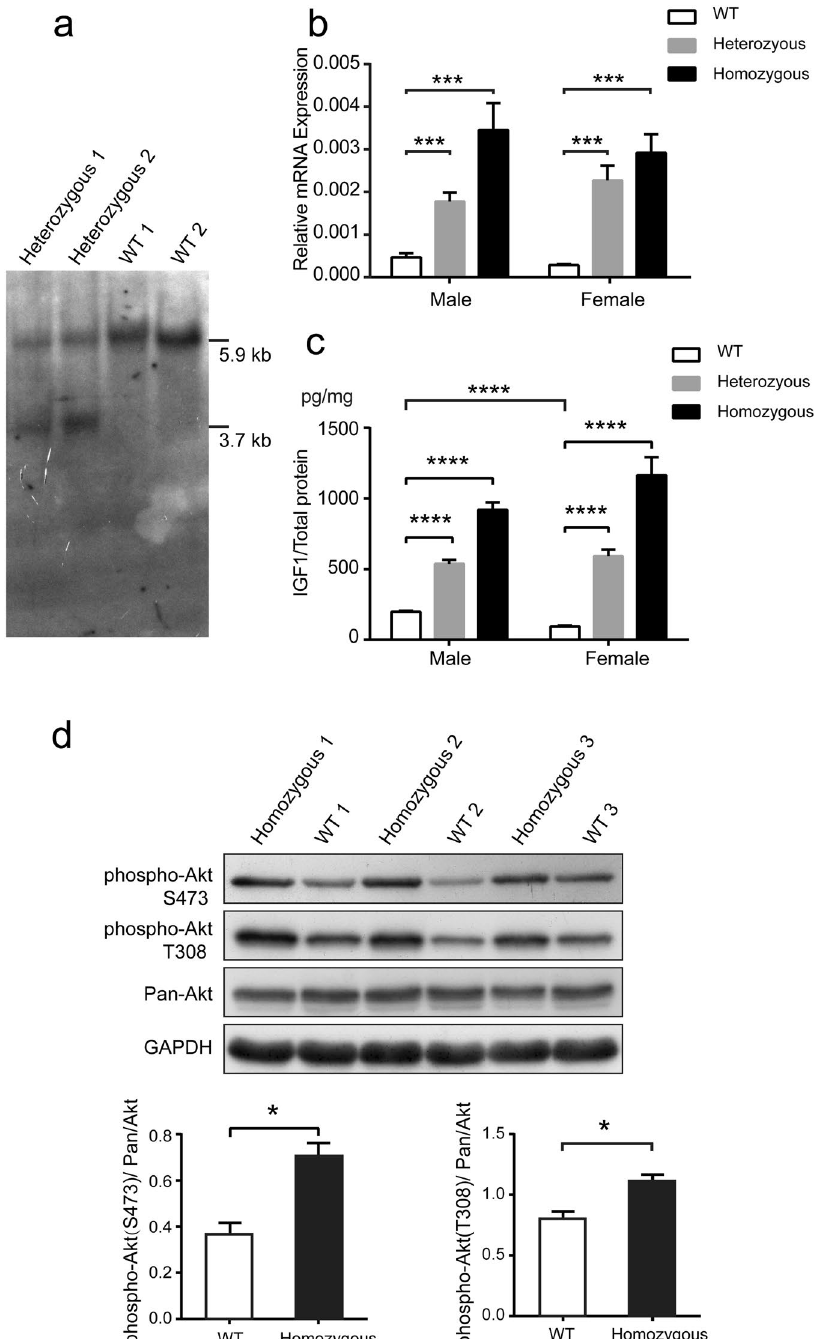
Figure 5. Analysis of IGF1 expression levels in the genetically modified mouse model. (a) The strategy for Southern blot analysis of incorporation of the MLC enhancer in GM mice is the same as that shown in Fig. 2c. Genomic DNA of heterozygous GM mice and WT control was digested with Hin dIII and then hybridized with the 3 ′ external probe. The expected fragment sizes are: WT, 5.9 kb; GM, 3.7 kb. (b) Real-time PCR analysis of Igf1 mRNA levels in the gastrocnemius muscle of two-month-old GM mice and WT littermates. (n = 11–13 per group). (c) ELISA analysis of total IGF1 protein levels in the gastrocnemius muscle of two-month-old GM mice and WT littermates. The total IGF1 protein levels were normalized to the total protein levels. (n = 10–13 per group). (d) Western blot analysis of the Akt phosphorylation levels in the gastrocnemius muscle of one-month-old female GM mice and WT littermates. Antibodies against phosphorylated Akt (Ser473), Akt (Thr308), and total Akt were used. GAPDH was used as a loading control. The ratio of phosphorylated Akt (Ser473)/Pan-Akt and phosphorylated Akt (Thr308)/Pan-Akt were determined by calculating the intensities of the blots and are shown below. All gels/blots were run under the same experimental conditions. Shown are cropped gels/blots (Full-length gels/blots with indicated cropping lines are shown in Supplementary Figure S10). Bars depict mean values, and error bars represent SEM. * P < 0.05, ** P < 0.01, *** P < 0.0001, **** P < 0.000001. Statistical significances were analysed by Student’s